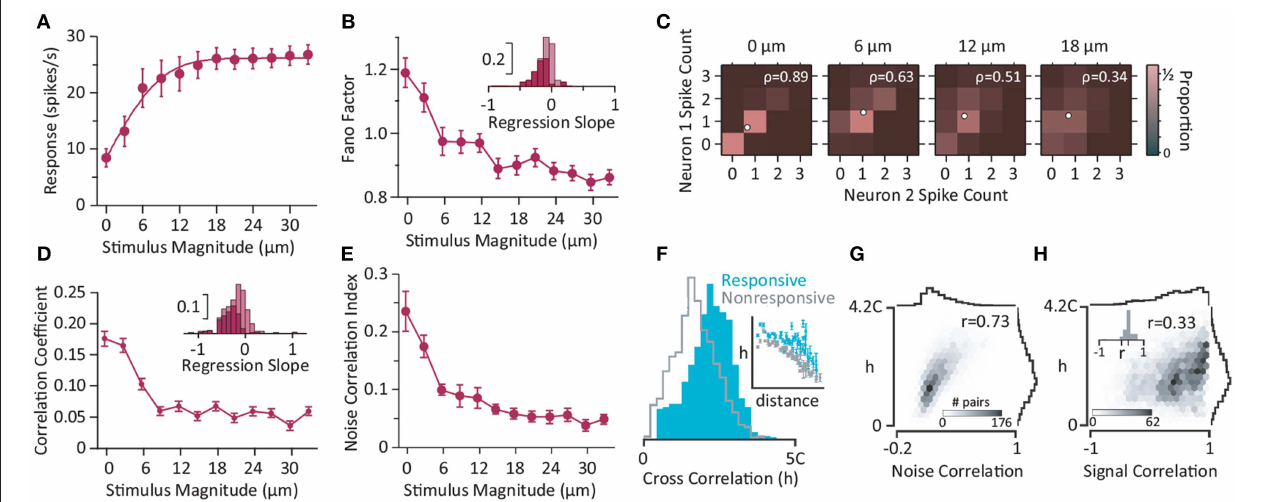
FIGURE 3 | Neural activity in somatosensory cortex. (A) The population activity increases with the magnitude of whisker deflection stimulation (single-cycle sine-wave at 80 Hz). Error bars represent the standard error of means across populations with more than five simultaneously recorded units ( n = 8). (B) Trial-to-trial variations in neuronal response (in terms of Fano factor) as a function of stimulus intensity for single neurons ( n = 64). The inset depicts the histogram of the linear regression slope of the Fano factor with respect to the z-scored neuronal activity for individual neurons. The dark bars correspond to recordings with a significant linear regression ( p <0.05). (C) Color indicates the proportion of joint spike counts for a pair of simultaneously recorded neurons. White circles indicate mean spike counts for each stimulus. The Pearson’s correlation coefficient of the spike counts is indicated by ρ for each panel. (D) The mean Pearson’s correlation coefficient across all possible pairs of neurons ( n = 245) as a function of stimulus intensity. Error bars indicate standard error of means. The inset depicts the histogram of regression slopes of noise correlation against average firing rate for pairs of neurons. Dark bars indicate the cases with significant linear regression ( p <0.05). (E) The noise correlation index (Adibi et al., 2013b) as a function of stimulus magnitude averaged across populations containing at least five simultaneously recorded neurons (data from A ). Error bars are standard error of mean across populations ( n = 8). Most of the neurons exhibit a negative slope indicating Fano factor (B) and noise correlations decrease with firing rate. (F) The strength of correlation, denoted by h: the peak of the cross correlation of a pair of electrodes relative to the chance level (denoted by C). Electrodes were divided into two groups of “Responsive” and “Nonresponsive” based on the median of the mutual information between neuronal responses and whisker stimulation. The distribution of h values for Responsive pairs (where both electrodes were from the Responsive group; cyan) and Nonresponsive pairs (where both electrodes in a pair were from the Nonresponsive group; gray). The inset depicts the average and standard error of means of strength of correlation, h, across electrode pairs as a function of their distance for each category. (G) The histogram shows the joint distribution of h values and noise correlations. r represents the correlation coefficient. (H) Same as (G) , but for signal correlation. Inset depicts the histogram of r value calculated for groups of electrode pairs with identical distance. The distribution of r values is positive with a mean of 0.3 indicating that the positive correlation between h and signal correlation is independent of the distance between electrodes and is present across all distances. (A–E) are based on Adibi et al. (2013b), and (F–H) are from Sabri et al.